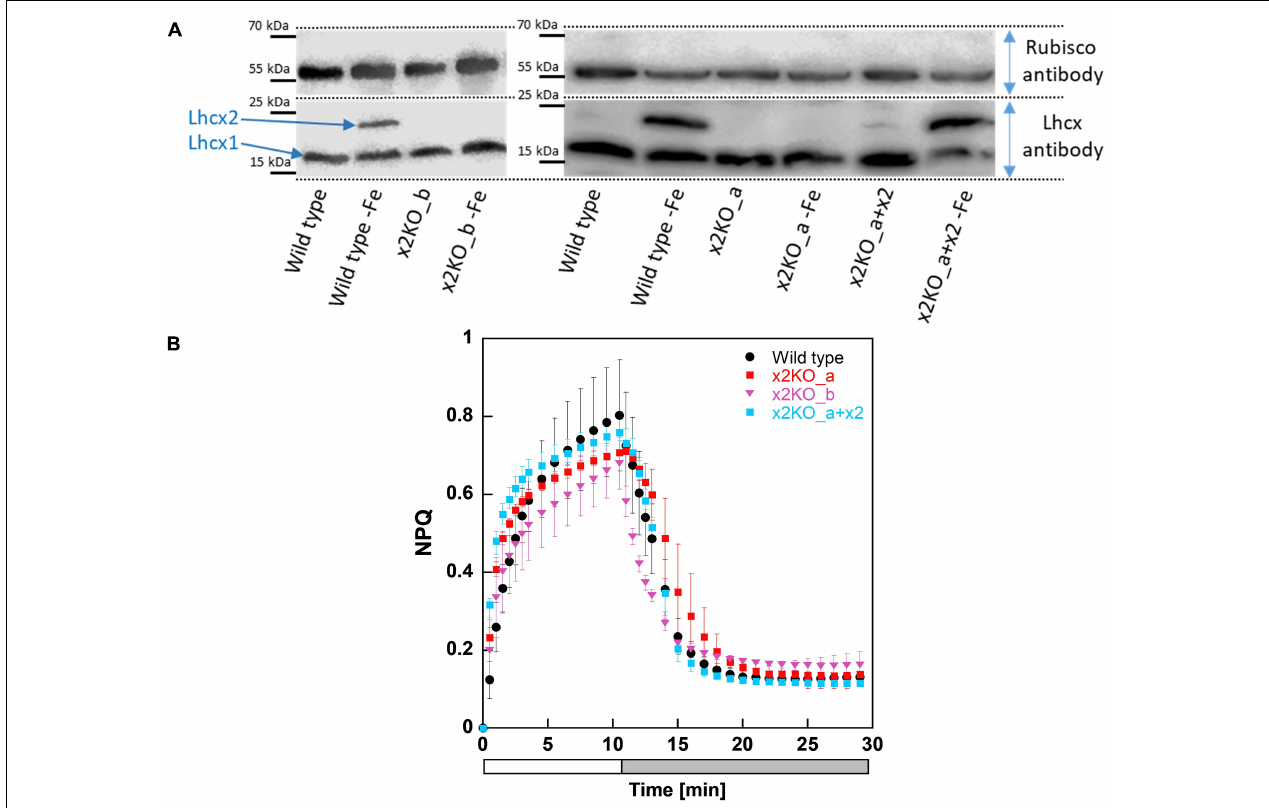
FIGURE 1 | Western blots and non-photochemical fluorescence quenching (NPQ) measurements of Phaeodactylum tricornutum wild type and Lhcx2 mutant lines. (A) Western blots under iron-limited and iron-replete conditions. Cells were harvested 7 days after inoculation to iron depleted and replete mediums and were kept under low light of 30–40- µ mol photons m − 2 s − 1 . The lower part of the blot was incubated with an Lhcx antibody, which recognizes each of the four Lhcx isoforms. The upper part, with a Rubisco antibody, serves as loading control. (B) NPQ measurements. Wild type in black, x2KO_a in red, x2KO_b in pink, and the complemented strain x2KO_a + x2 in light blue. Low-light acclimated cells were concentrated to 10 mg Chl a L − 1 , exposed to 1,700- µ mol photons m − 2 s − 1 for 10 min (a white bar), followed by 18 min of low light (a gray bar). Each experiment was performed in three or four biological replicates. SD is given. Data for preparing the graph for wild type were taken from Buck et al.